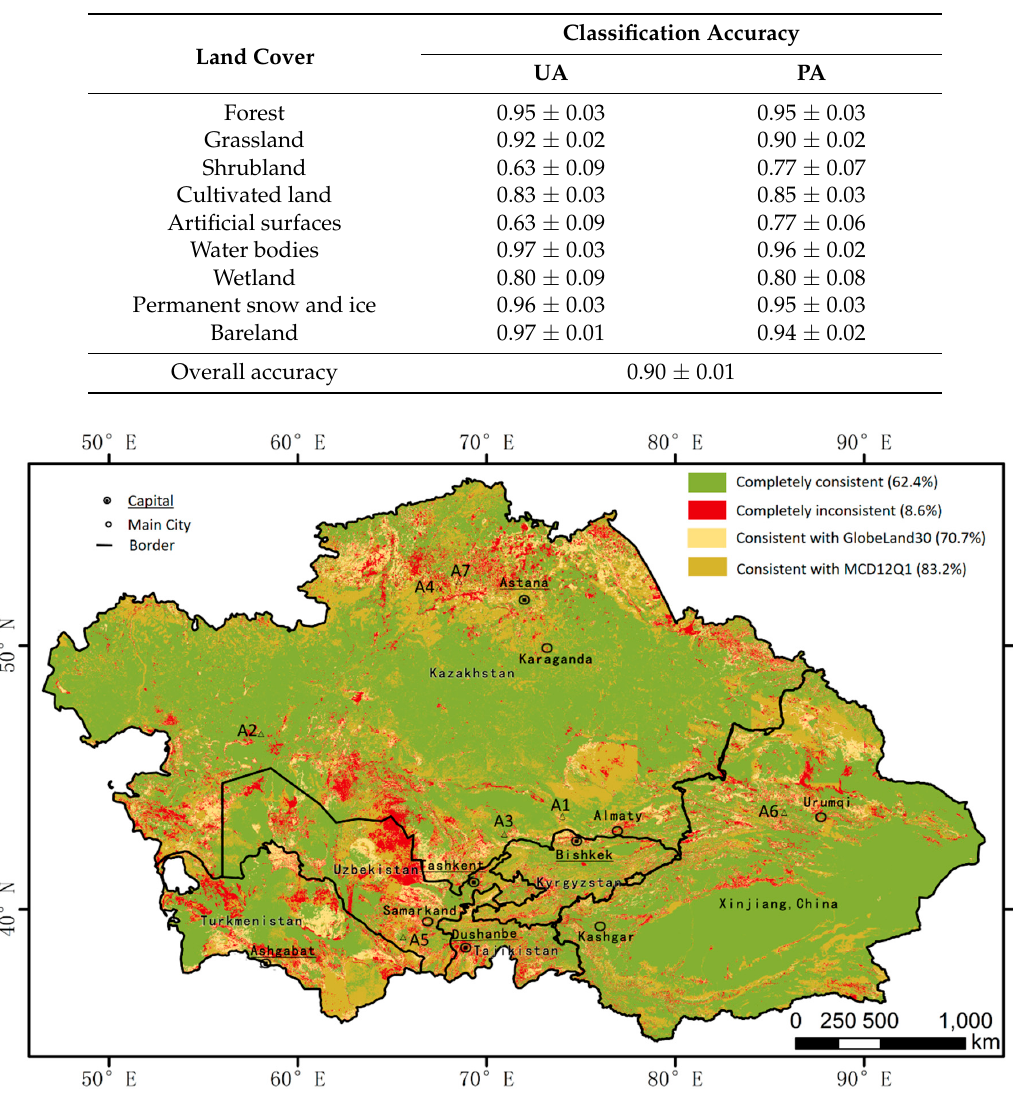
Figure 3. Spatial distribution and consistency analysis of land cover from the products obtained in this study in 2010 and the GlobeLand30_2010 and MCD12Q1 products in 2010. A1-7 represents the 7 comparison areas in Figure 4.